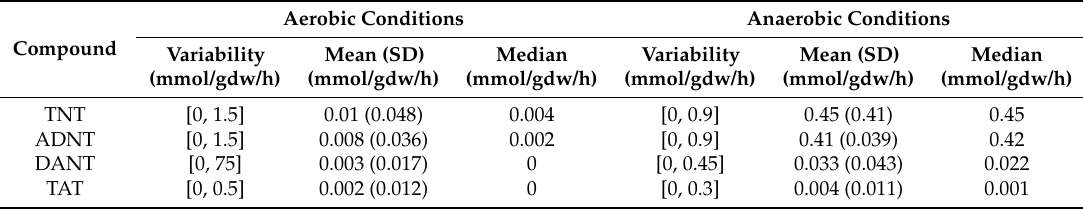
Table 1. Variability, mean, and median of TNT uptake rate (TNTUR) and fluxes through reduced metabolites.